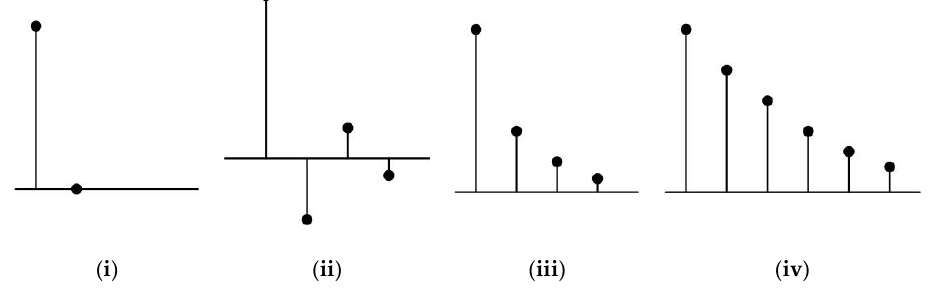
Figure 10. Corresponding impulse responses with respect to EV locations specified in Figure 9 (a) and (b). ( i ) deadbeat response; ( ii ) forced oscillation; ( iii ) underdamped response of DB-DTFC; (iv) underdamped response of CVC.